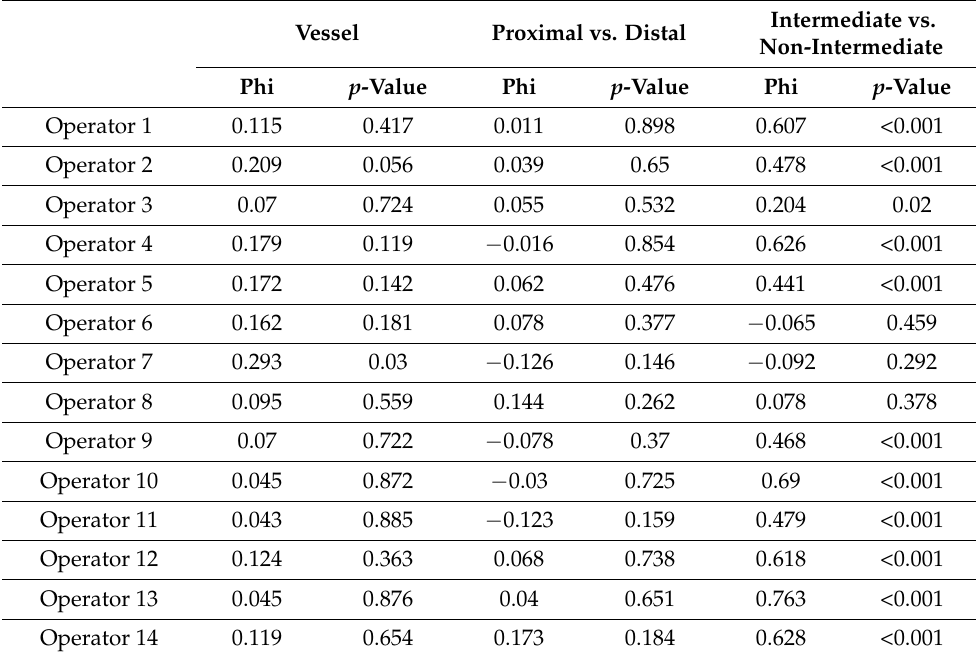
Table 3. Correlations for the decision to perform functional invasive assessment.